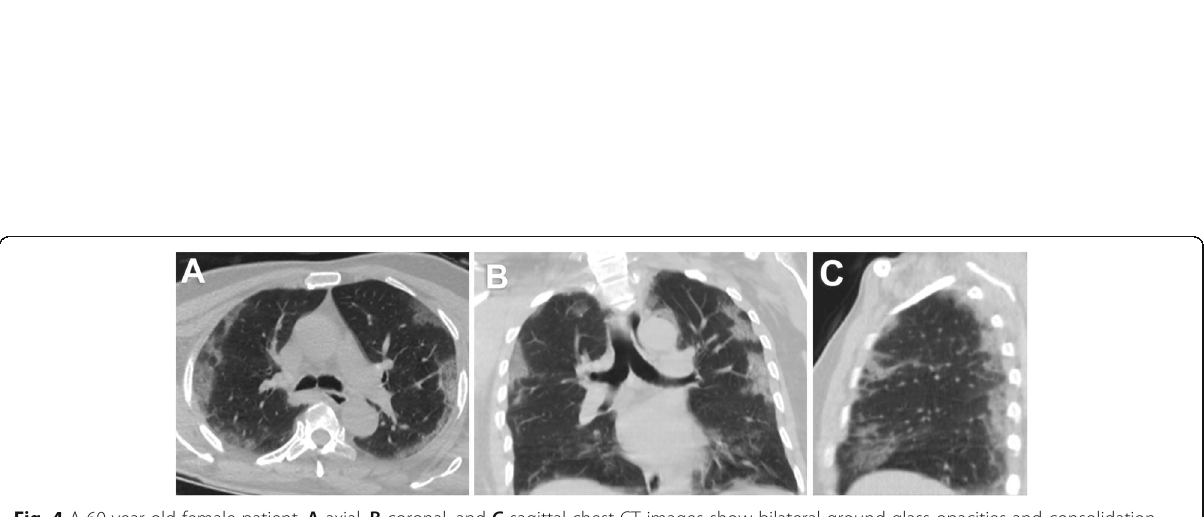
Fig. 4 A 60-year-old female patient. A axial, B coronal, and C sagittal chest CT images show bilateral ground-glass opacities and consolidation with moderate pulmonary involvement (26 – 49%) corresponds to current chest CT score 13 and simple chest CT score 3 (moderate affection). The